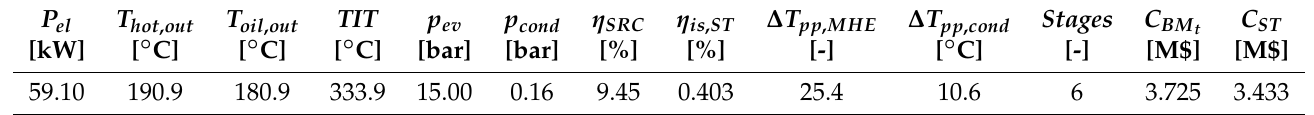
Table A7. Most promising ORC fluids in the case of direct exchange between ICE’s exhaust and the cycle. Fluid